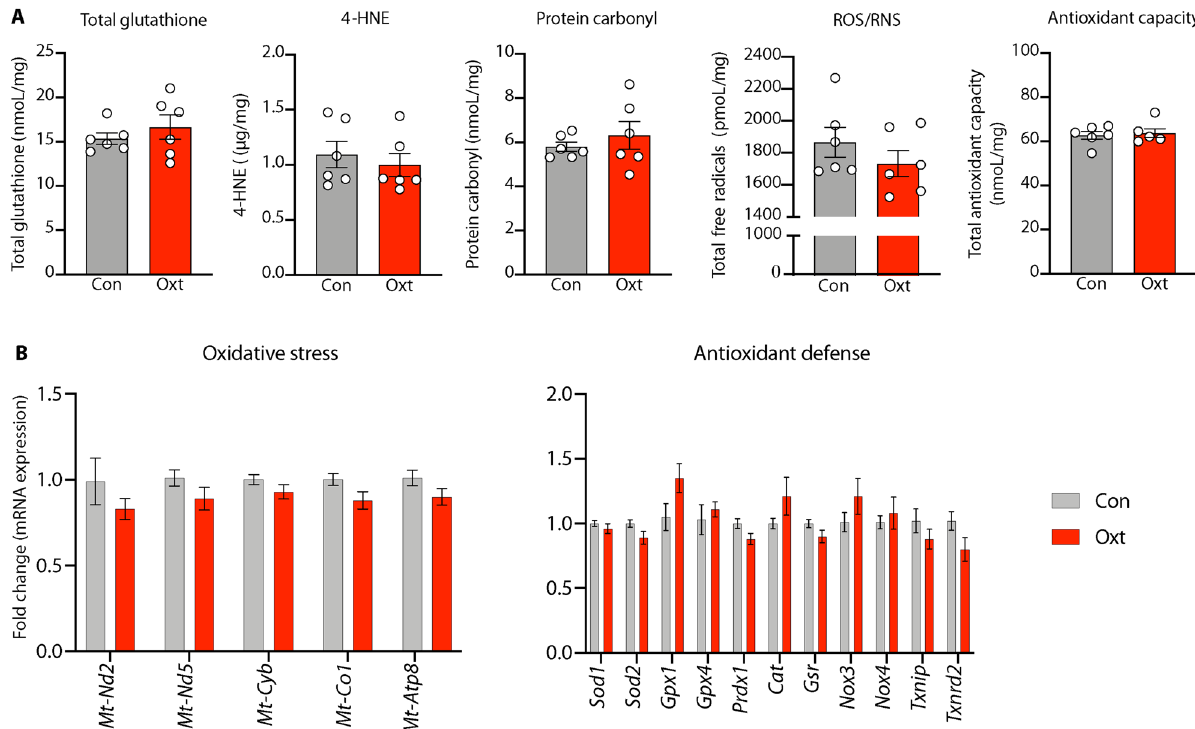
Figure 5. Labor induction with oxytocin is not associated with oxidative stress in the developing brain. ( A ) From left to right: Labor induction with oxytocin was not associated with an increase in either glutathione, 4-hydroxynonenal, protein carbonyl, reactive oxygen/nitrogen species (ROS/RNS), or total antioxidant capacity in the developing fetal cortex. All data are presented per mg of brain protein. Fetal brains exposed to paraquat in utero served as positive control. ( B ) Expression of genes mediating oxidative stress or antioxidant defense were not significantly differentially expressed in the fetal cortex after labor induction with oxytocin. Collectively, these data indicate that labor induction with Oxt is unlikely to be associated with oxidative stress in the developing brain. Data were analyzed with Welch’s t-test and expressed as mean ± SEM (n = 5–8 per treatment condition with pups represented from all unique